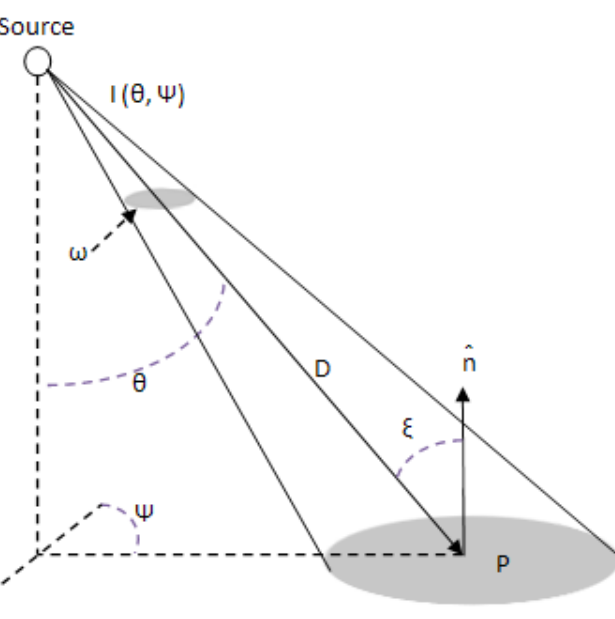
Figure 4. Light source in spherical